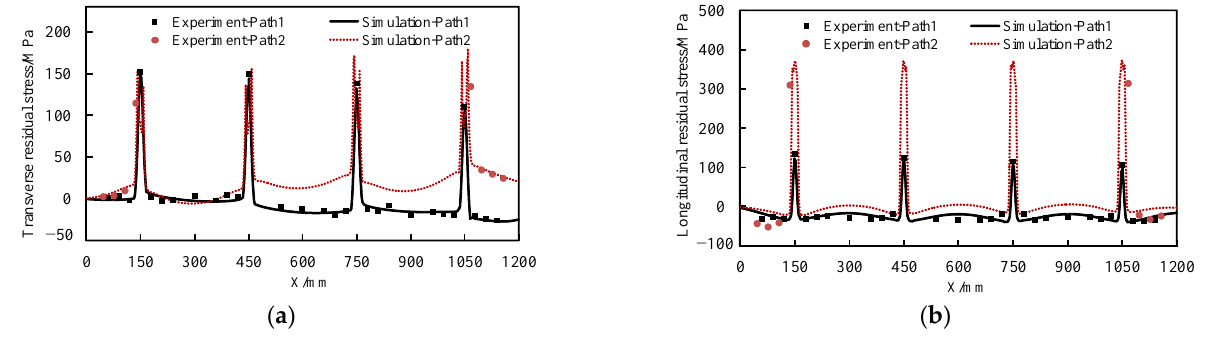
Figure 8. Distribution of σ x and σ z on Paths P1 and P2: ( a ) σ x ; ( b ) σ z Paths P3 (P6) and P4 (P5) are laid out to measure the residual stresses along the